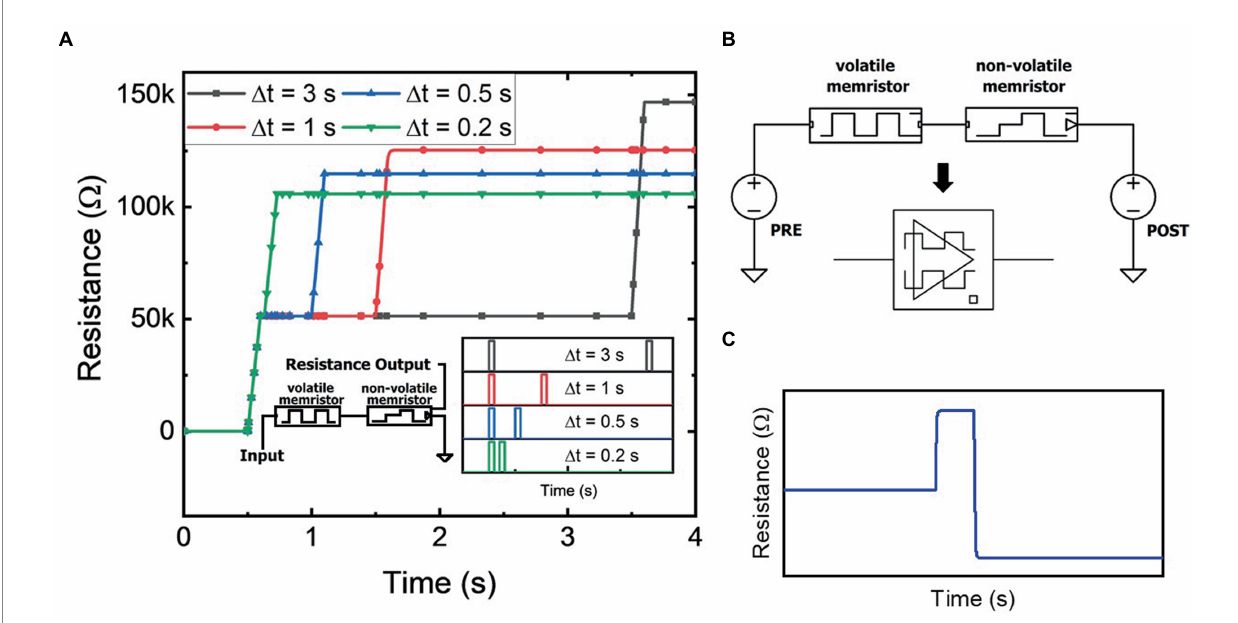
FIGURE 3 (A) Resistance of the non-volatile memristor in the desensitization circuit (left inset) from two identical input pulses with varied time separation (right inset). (B) Bidirectional memristor temporal circuit diagram and circuit symbol. (C) Resistance of the non-volatile memristor in the memristive circuit from bidirectional pulses within the temporal window. The overall decrease in resistance due to the temporal relationship between the input pulses demonstrates the effect of sensitization or paired-pulse facilitation.